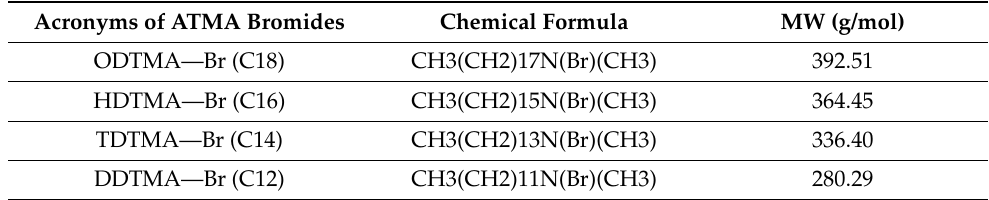
Table 1. Chemical properties of the four ATMA-Br used in this study. Acronyms of ATMA Bromides Chemical